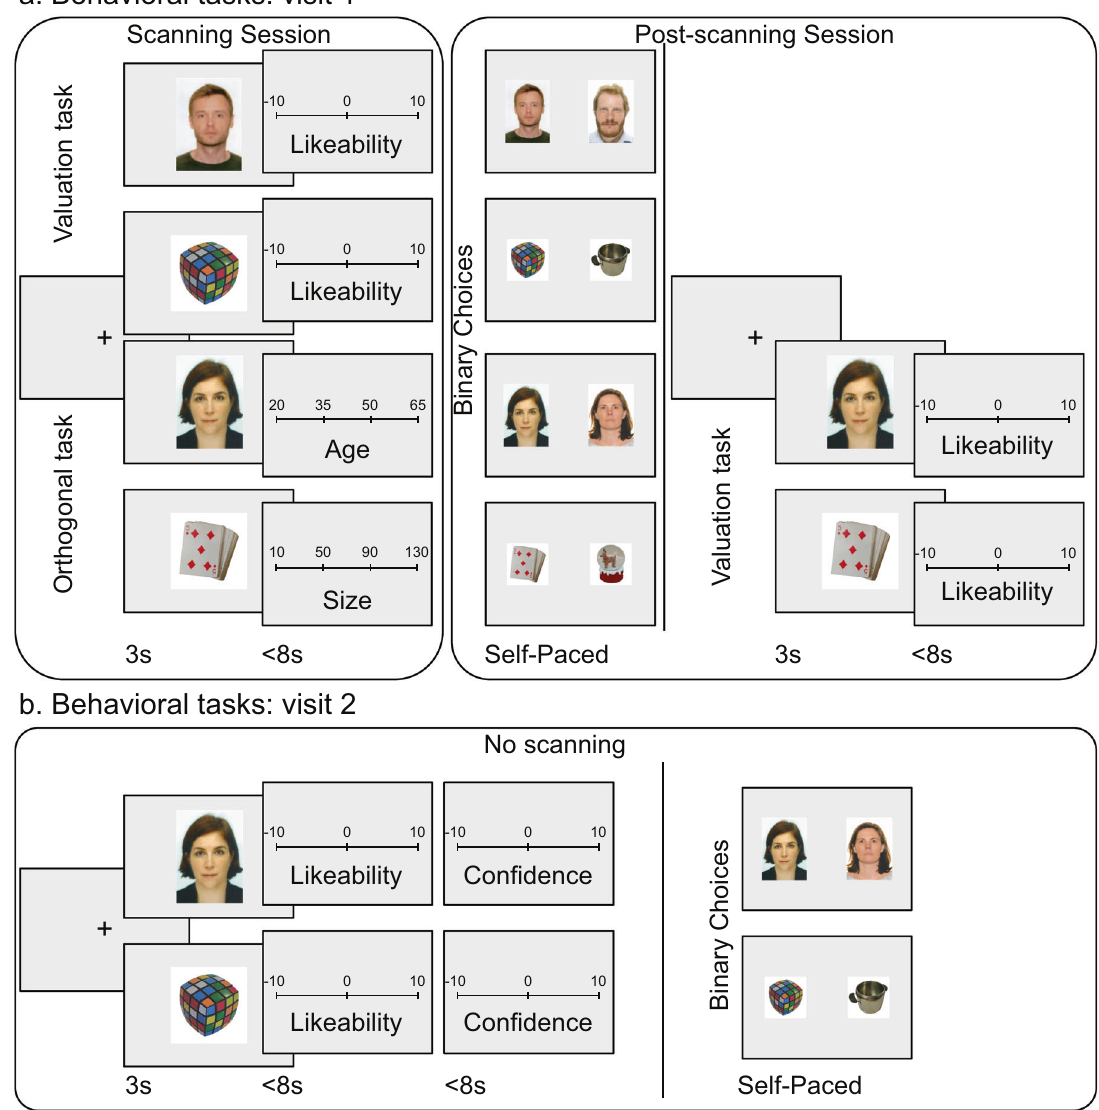
Fig. 1 Behavioral tasks. a Visit 1. During the scanning session (left), participants performed the valuation task (likeability rating) on half the items and an orthogonal task (age rating for faces and size rating for objects) on the other half. Each of the four blocks comprised 84 items in a randomized order. The order of the four blocks was randomized as well. After the scanning session (right), participants performed a series of 336 choices between two stimuli of the same category. Faces were paired by gender. Objects were paired such that the prices of the two items was approximatively matched. b Visit 2. The second visit took place around 4 weeks later and involved no scanning. Participants performed fi rst the valuation task, augmented with a second-order rating (of how con fi dent they were in their likeability rating), on all the items. Then, they were required to make the same series of choices as in the fi rst visit, in the same After the scanning sessions, participants were fi rst asked to make a rating, on a scale between − 10 (not at all) and 10 (fully). Then, they were series of 336 choices between two stimuli of the same category and the required to make the same series of choices than in the fi rst visit, in the same sub-list. Faces were paired by gender. Objects were paired such that same order. Please note that as the orthogonal tasks were not performed the prices of the two items were approximatively matched. Face and in the second visit, con fi dence estimates were not collected for age/size object pairs were intermixed in a pseudo-randomized order. At the trial ratings. level, after a fi xation cross, the two items were presented simultaneously, All tasks were programmed using the Matlab and Psychtoolbox 3.0.11 one on each side of the screen. The choice was self-paced, and participants [31] (http://psychtoolbox.org/). chose by pressing the left or the right arrow of the keyboard. Then, participants were required to rate the likeability of the stimuli used in the Behavioral analyses orthogonal task, following the same procedure as inside the scanner. Likeability and orthogonal ratings . Average and standard deviation (SD) of ratings were computed for each participant and each domain (faces/ Second visit . During the second visit, participants were fi rst required to objects) and entered in ANOVAs with the domain as within-subject factor, perform the valuation task again for all images. The procedure and the group as between-subject factor, and subject as a random factor. We also order of images was the same as in the fi rst visit, except that after the assessed the stability of ratings using two measures: averaged item-wise likeability rating, they also had to rate how con fi dent they were in their